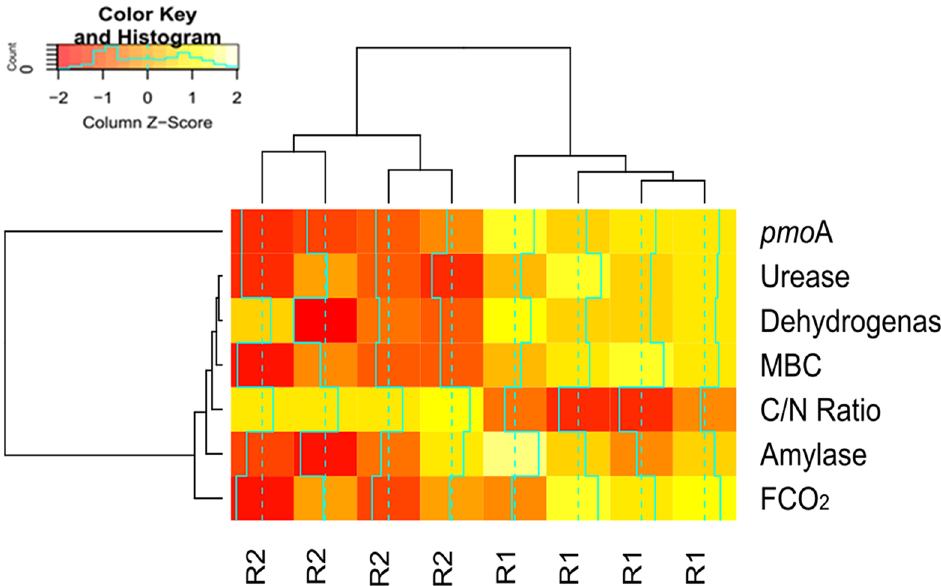
Figure 4. Heatmap graph (r = 0.89; p < 0.0001). Dendrogram showing the hierarchy of groups (regions of the reform area) resulting from the clustering analysis by the hierarchical method. Heatmap shows the variations of soil attributes as a function of management. The dendrogram above the heatmap represents the clustering of regions based on similar patterns of variation. Heatmaps were processed using the package gplots in the software R version 3.6.3 49 (https:// cran.r- proje ct. org/ bin/ windo ws/ base/ old/3.